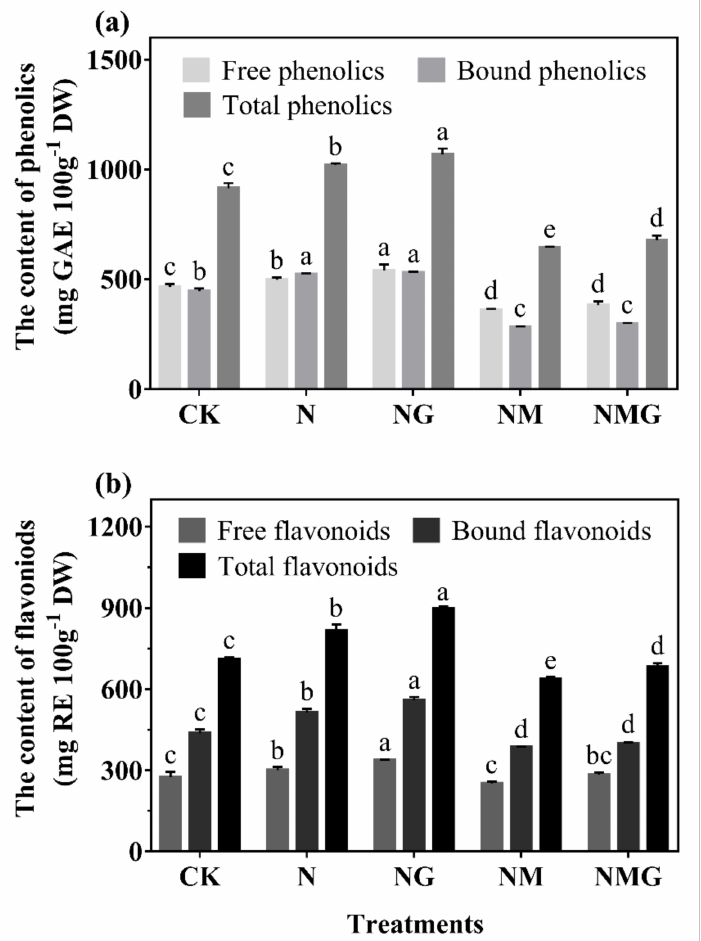
Figure 3. The effect of GABA on phenolics ( a ) and flavonoids ( b ) contents in 6-day-old barley seedlings under 20 mmol L − 1 NaCl. The lower case letters indicate significant differences at p < 0.05 among different treatments. One-way ANOVA was used. The data are presented as mean ± SD, n ≥ 3. The antioxidant capacities of free, bound, and total phenolics of 6-day-old barley seedlings under N and NG treatment significantly improved with a large amount of phenolics (Figure 4). ABTS free radical scavenging capacity of total phenolics increased by 6.90% and 9.28% under N and NG treatments compared with the control, respectively, while DPPH free radical scavenging ability increased by 6.78% and 13.16% compared with the control, respectively. In addition, bound phenolics had a greater contribution to ABTS free radical scavenging ability, while free phenolics had a greater contribution to DPPH free radical scavenging